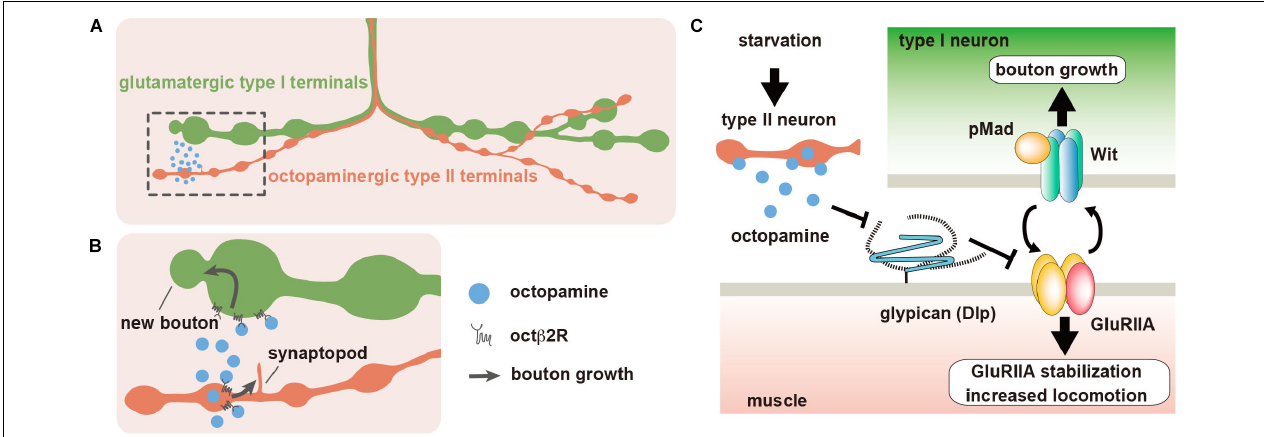
FIGURE 2 | Dlp regulates synaptic plasticity at the Drosophila neuromuscular junction (NMJ). (A) The body wall muscles of Drosophila larva are innervated by type I glutamatergic motor neurons, which form synaptic boutons at the NMJs. Most larval body wall muscles are also innervated by octopaminergic type II neurons. (B) When larvae are placed under food deprivation conditions, octopamine is released from the type II boutons, and type II arbors rapidly extend new branches called synaptopods through the activation of Oct β 2R octopamine autoreceptors. The acute acceleration of octopamine signaling by the growth of type II boutons leads to the rapid growth of type I boutons, which also express Oct β 2R, and the increase of larval locomotor speed. (C) The expression of Dlp, which is a homolog of mammalian GPC4 and GPC6, is downregulated by octopamine signaling. Dlp suppresses the non-canonical BMP pathway that is composed of BMP receptor Wit and GluRIIA-containing iGluRs. Starvation-induced octopamine signaling downregulates Dlp expression, which leads to the activation of the non-canonical BMP signaling. TABLE 1 | Dysregulation of glutamate receptors, behavioral defects, and mental disorders associated with GPC and HS-related genes. Fruit fly Mouse Human